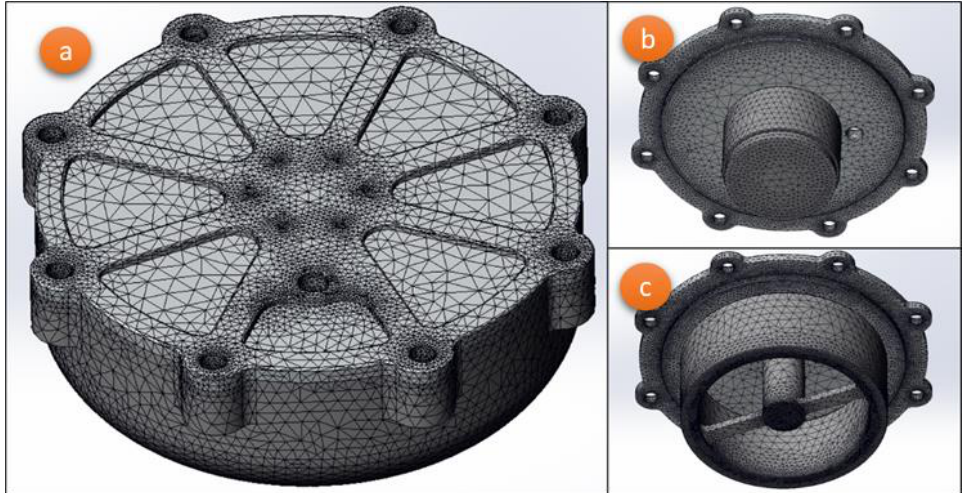
Figure 9. Mesh refinement details: WCH assembly ( a ), lid + 24 V pillar ( b ), and lid + 48 V pillar ( c ).